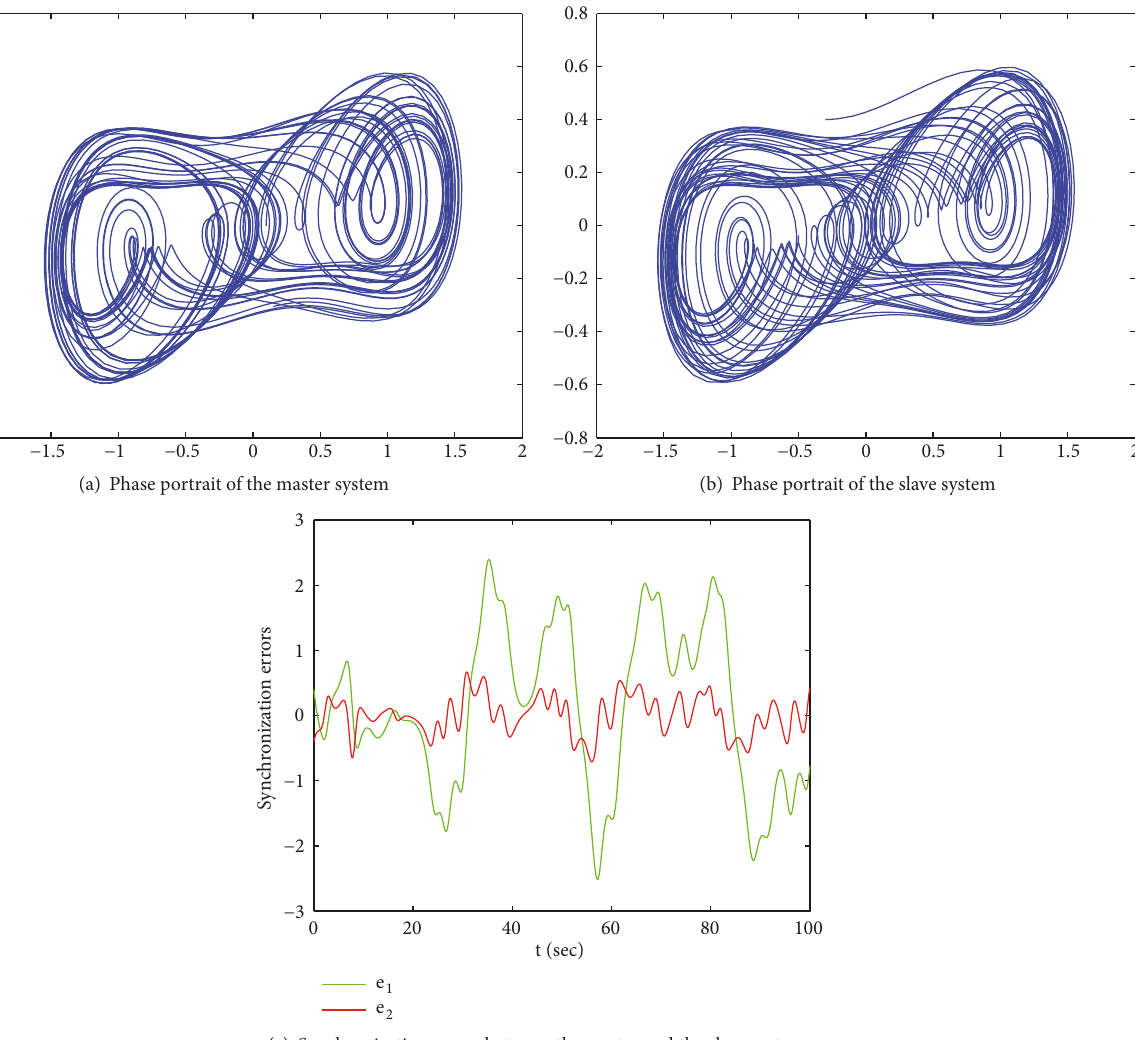
Figure 1: Behavior of the master-slave systems without control